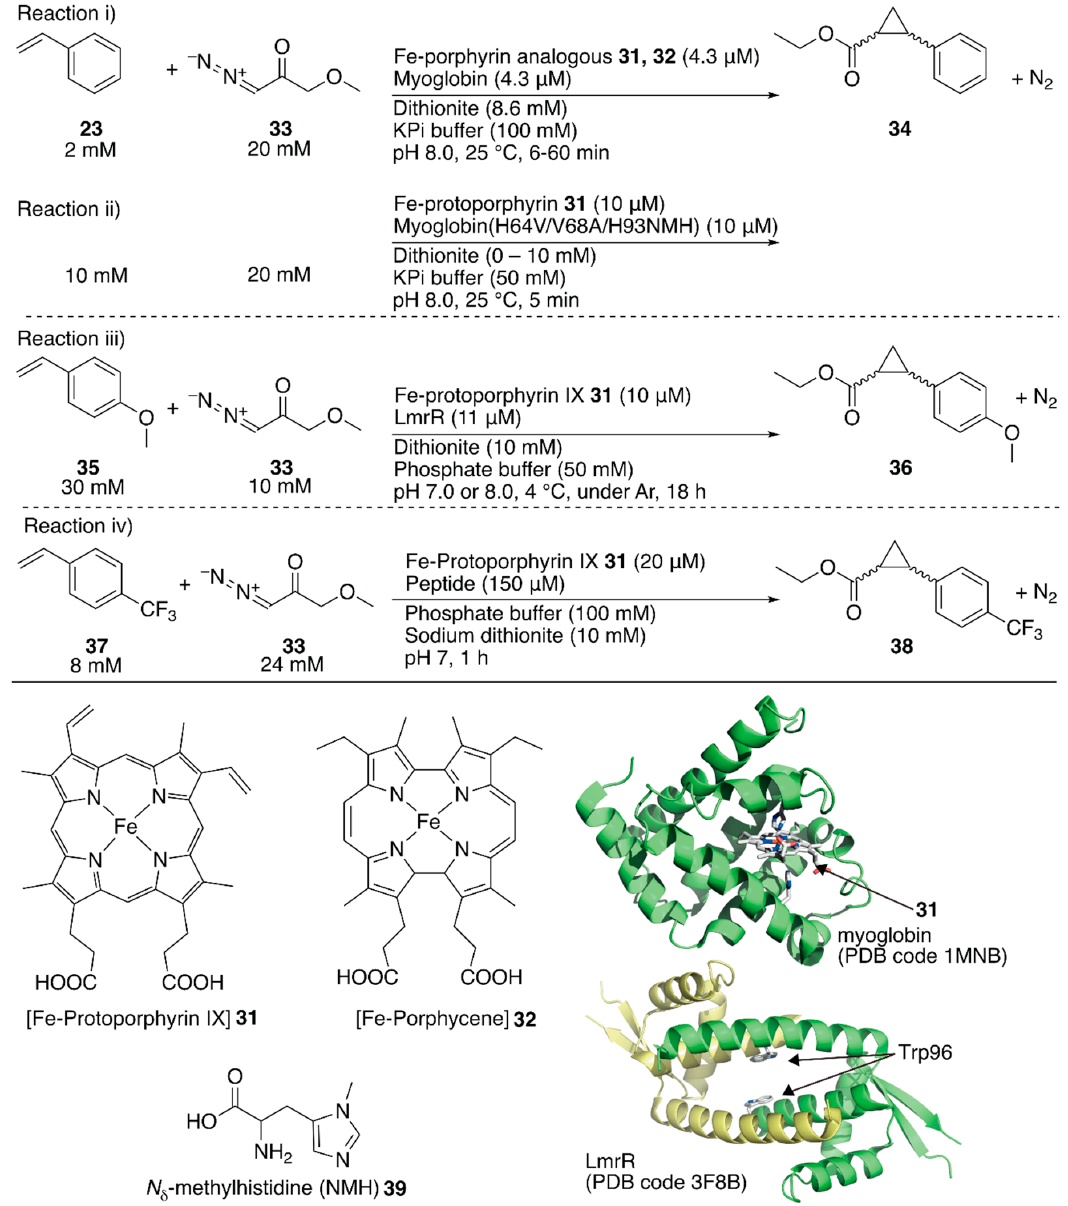
Figure 7. Cyclopropanation catalyzed by ArMs containing iron porphyrinoids as their cofactor. Adapted from [55,58,59,62].